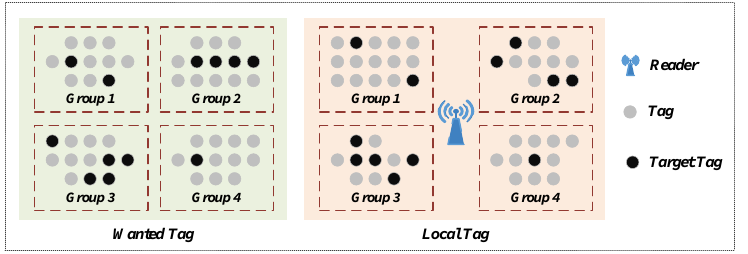
Figure 1. Illustration of the tag searching problem in a multi-group RFID